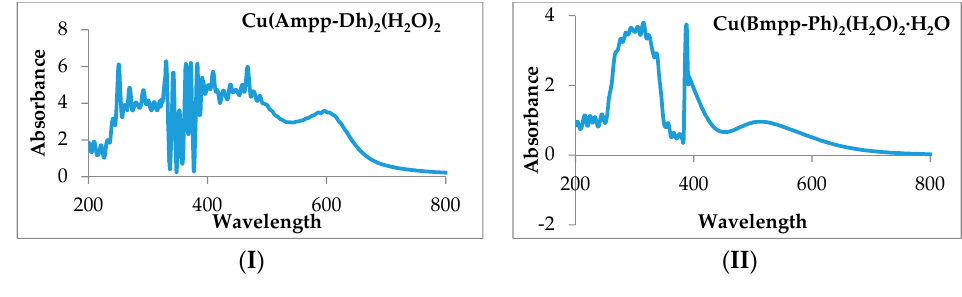
Figure 10. ( I ) Electronic spectra of Cu(Ampp-Dh) 2 (H 2 O) 2 ; and ( II ) electronic spectra of Cu(Bmpp-Ph) 2 (H 2 O) 2 ∙ H 2 O.